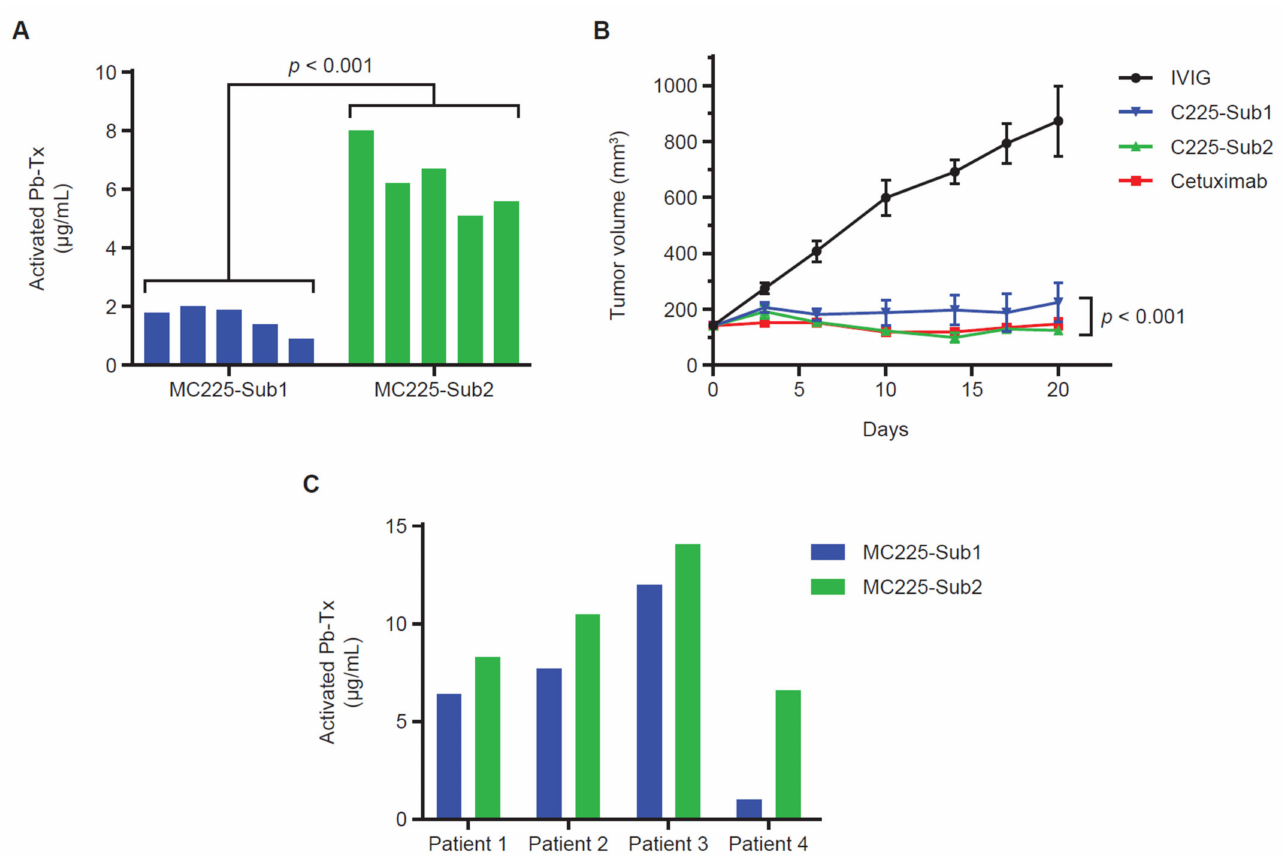
Figure 5. Sub1 vs. Sub2 activation in xenograft models and human tumor tissue. ( A ) Quantitative zymography (QZ) assessment of C225 Probody therapeutics (Pb-Tx) activation with H292 cell line-derived xenograft (CDX) tissue. A total of 20 µ g/mL of MC225-Sub1 or MC225-Sub2 was incubated for 48 h at 37 ◦ C with tissue sections from H292 CDX tumors ( n = 5). ( B ) In vivo efficacy at 10 mg/kg (mpk) of the C225 Pb-Tx with Sub1 or Sub2 substrates compared to cetuximab and intravenous immunoglobulin therapy (IVIG) in the H292 xenograft model ( n = 8 mice per group). ( C ) QZ assessment of MC225-Sub1 and MC225-Sub2 Pb-Tx activation with cholangiocarcinoma patient tissues ( n = 4). Statistical significance was calculated by Student’s t